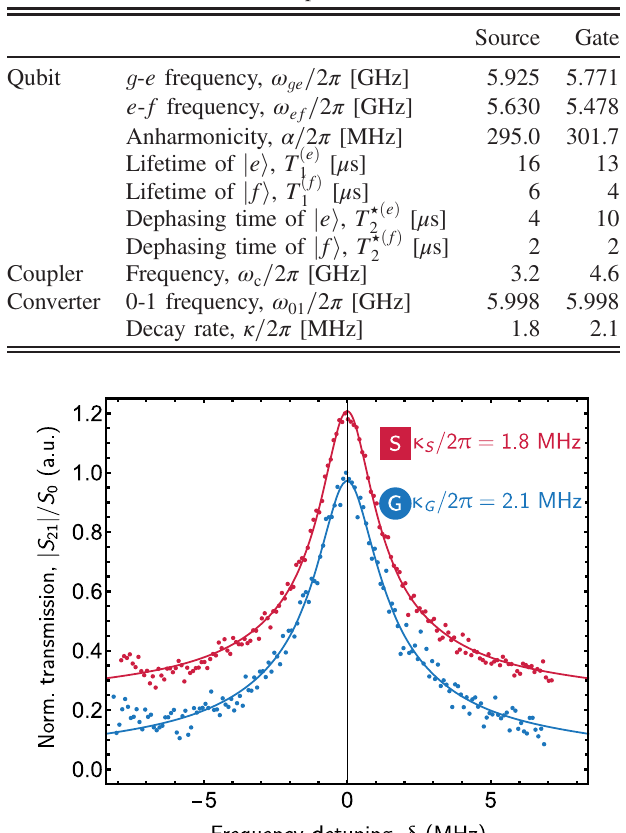
TABLE II. Measured device parameters.